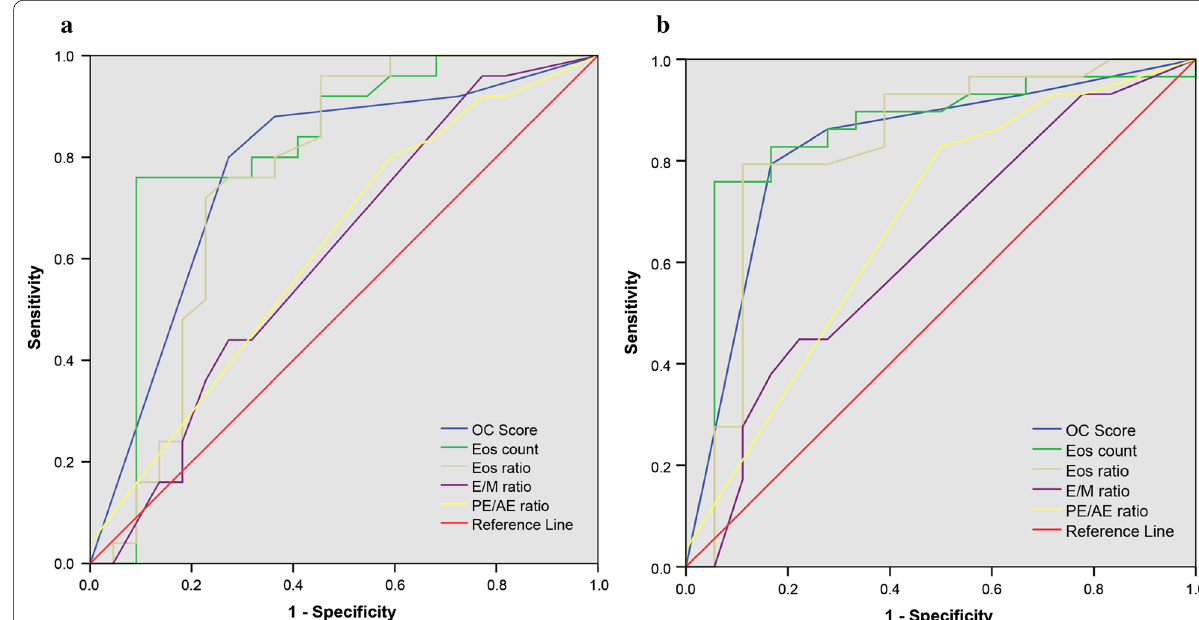
Fig. 1 The receiver operating characteristic (ROC) curve for olfactory cleft (OC) score and other clinical parameters. Area under the ROC curve (AUC) of OC score was 0.775 (95% confidence interval, 0.633–0.916) for objective GC-sensitivity ( a ), and 0.829 (95% confidence interval, 0.699–0.958) for subjective GC-sensitivity ( b )